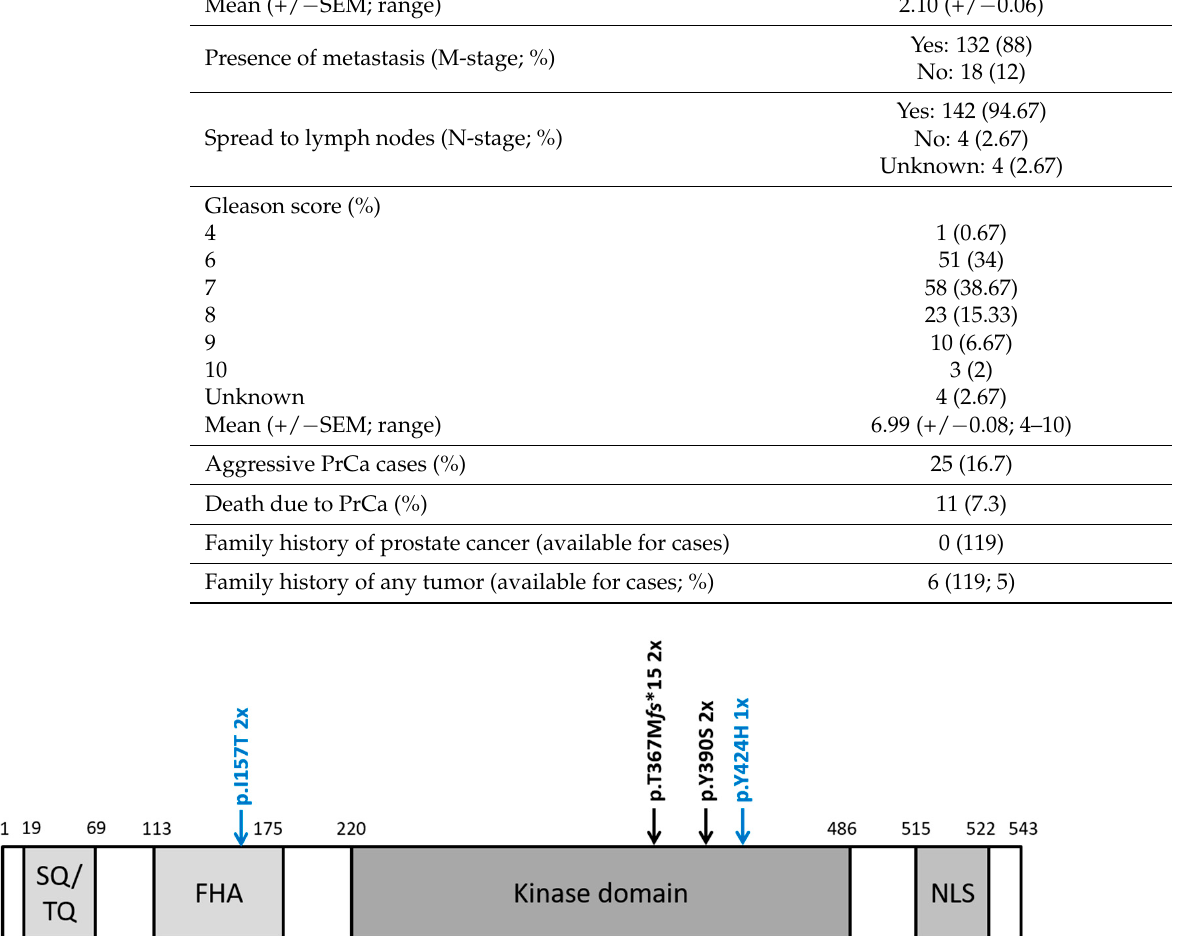
Figure 1. Location of identified CHEK2 variants. Schematic protein structure of CHK2 showing conserved domains. SQ/TQ: SQ/TQ cluster domain; FHA: forkhead-associated domain; kinase domain; NLS: nuclear localization signal. Pathogenic and likely pathogenic variants are shown in black above the protein structure; the other variants are shown in blue.